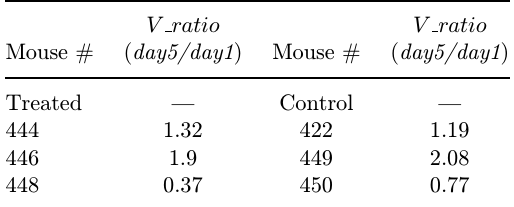
Table 1. Tumor volume